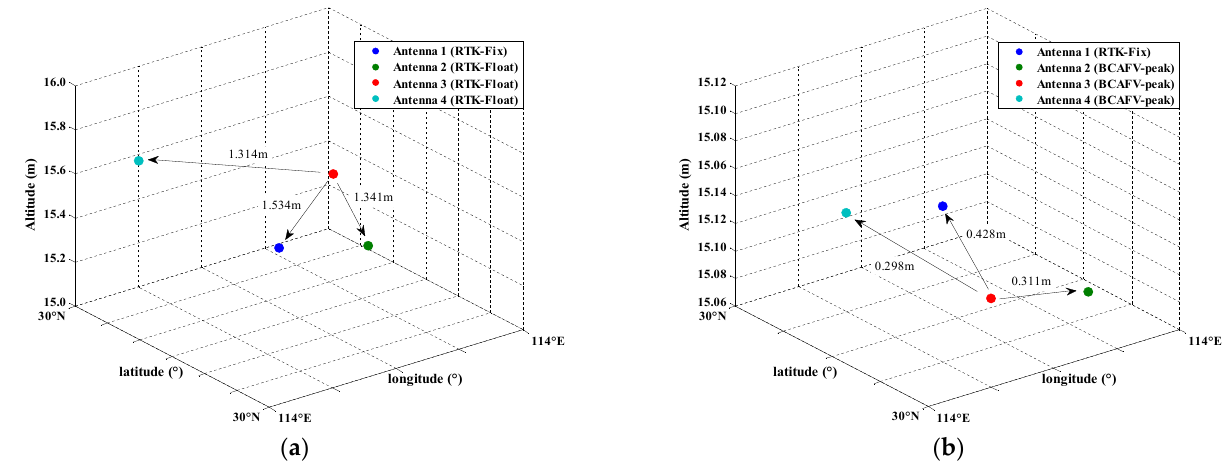
Figure 10. Spatial distribution of four antennas in different positioning modes. ( a ) Antenna 1 is the fixed solution position of RTK, and antennas 2, 3 and 4 are all float solution positions. ( b ) Antenna 2, 3, and 4 are all the positions searched by BCAFM and the position of antenna 3 is the coordinate corresponding to the peak value.